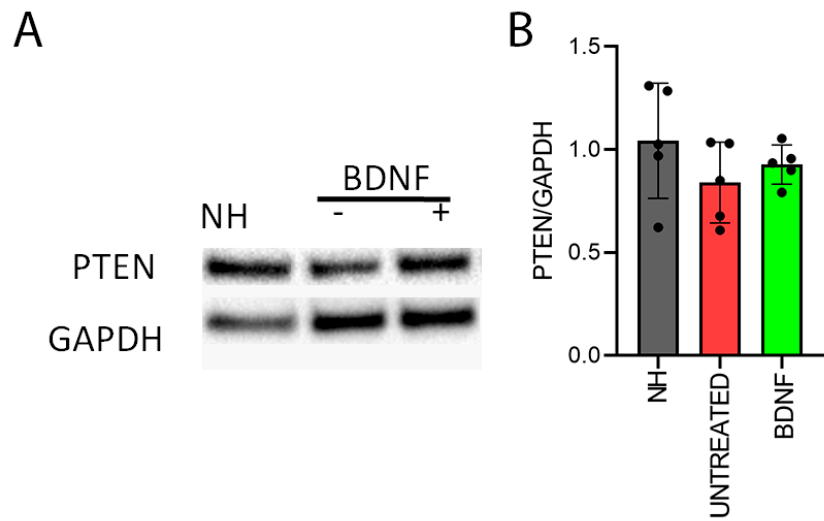
Figure 13. Protein quantification of PTEN. ( A ) Representative Western blot bands. (The original Western blot bands are shown in Supplementary Figure S3). ( B ) Western blot analysis of PTEN/GAPDH on organ of Corti samples from all the experimental groups. The histogram shows mean ± SD; the dots indicate the densitometric values for individual samples ( n = 5; each sample is a pool of two organs of Corti).